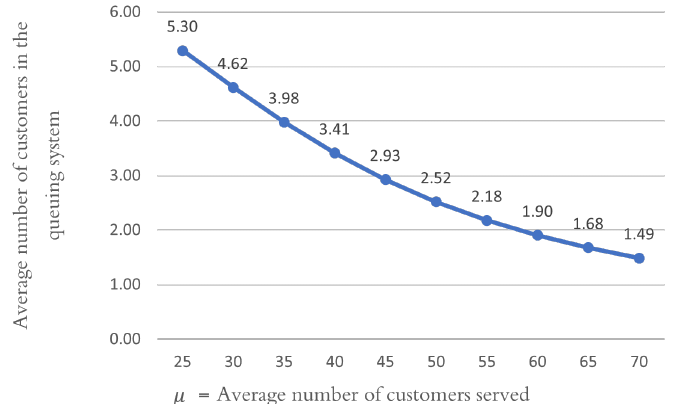
Figure 3. Effect of changing the speed of service with respect to the number of customers in a queuing system under a deterministic order size.